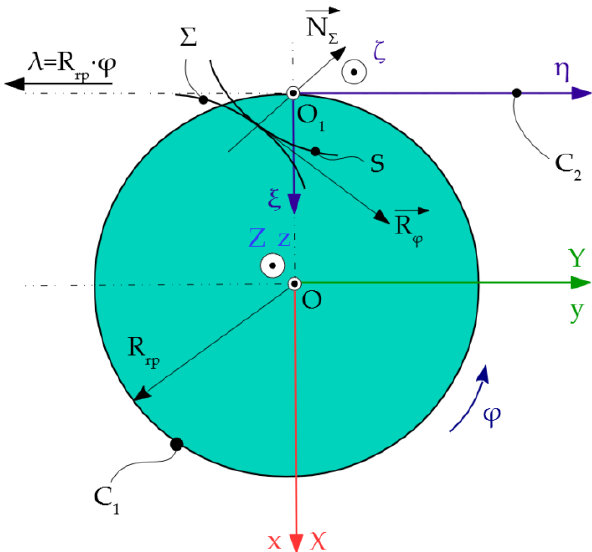
Figure 7. Reference systems for generating with rack tool, xyz is the fixed reference system, XYZ —mobile reference system, joined with the Σ profile, ξηζ —mobile reference system, joined with the rack tool.